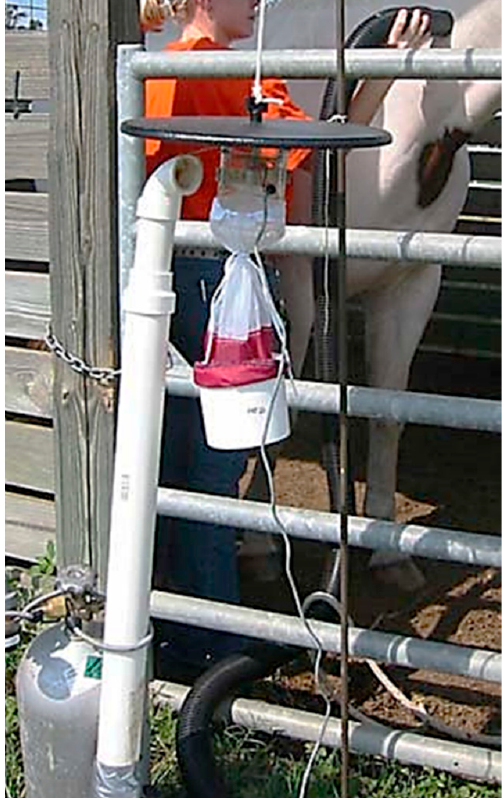
Figure 5. Fabricated vacuum system for adding horse odors to the airstream of a CDC trap. A 2 in diameter, 3 m long flexible, plastic shop vacuum hose was connected to a 2 in diameter polyvinylchloride (PVC) pipe with a 90-degree elbow. The open end of the elbow was connected to a length of 2 in diameter PVC pipe long enough to reach the air intake area near the top of a CDC trap when the pipe was placed vertically on the ground and the CDC 1012 trap was on a shepherd’s hook as described above. A second 2 in diameter 90-degree elbow PVC pipe was placed on the top of the vertical PVC pipe with the open end directed towards the CDC 1012 trap. The vertical PVC pipe was held in place by securing it to the compressed gas cylinder that supplied the CO 2 for the trap. A battery-powered in-line fan was mounted inside the PVC pipe to create the suction needed to pull air into the shop vacuum hose near the horse and blow it out the top end of the vertically mounted PVC pipe near the trap